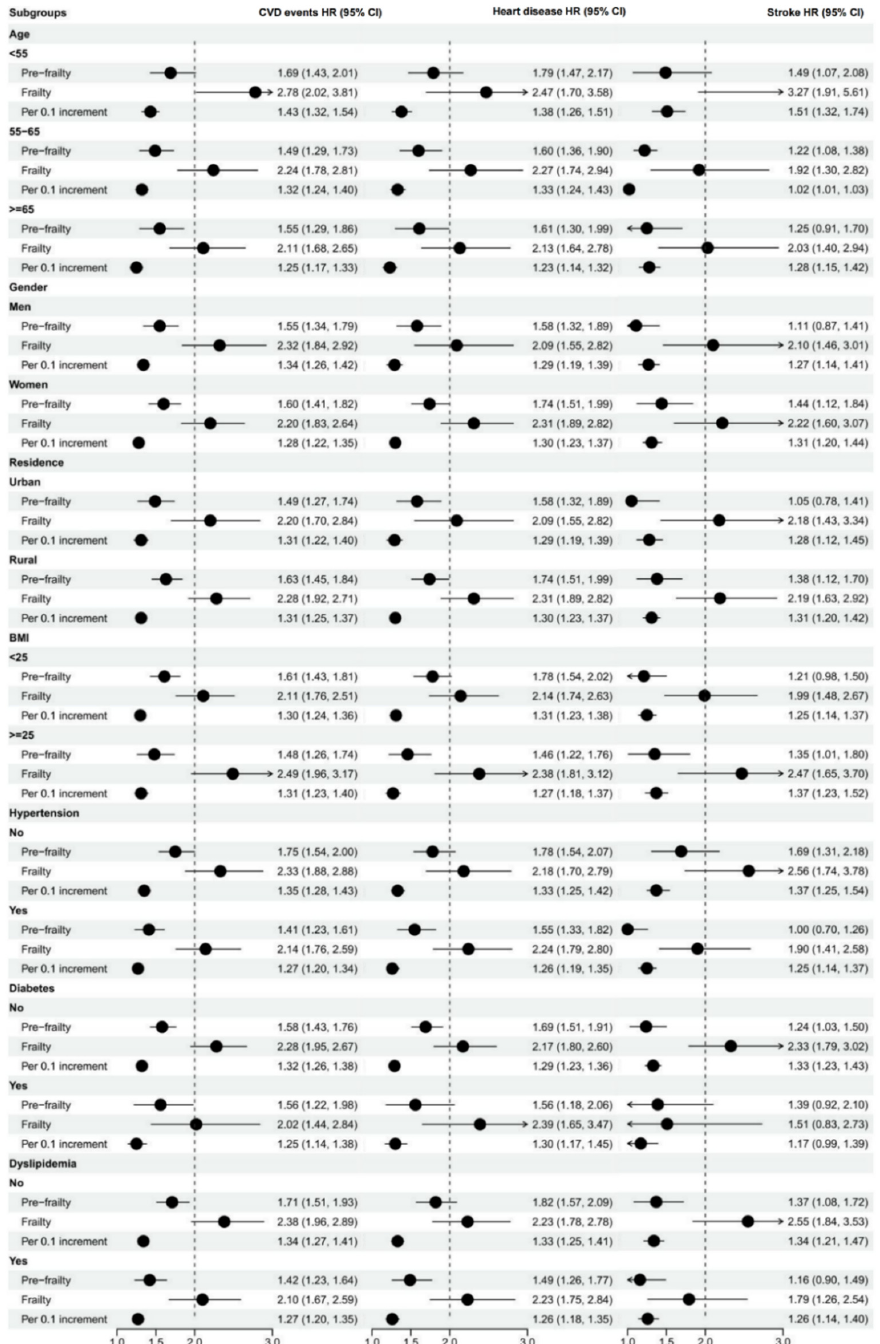
Figure 3. Longitudinal association between the frailty index and CVD events stratified by age, gender, residence, BMI, and chronic disease status. Model was adjusted for age, gender, educational level, marital status, residence, smoking status, drinking status, hypertension, diabetes mellitus, dyslipidemia and BMI.